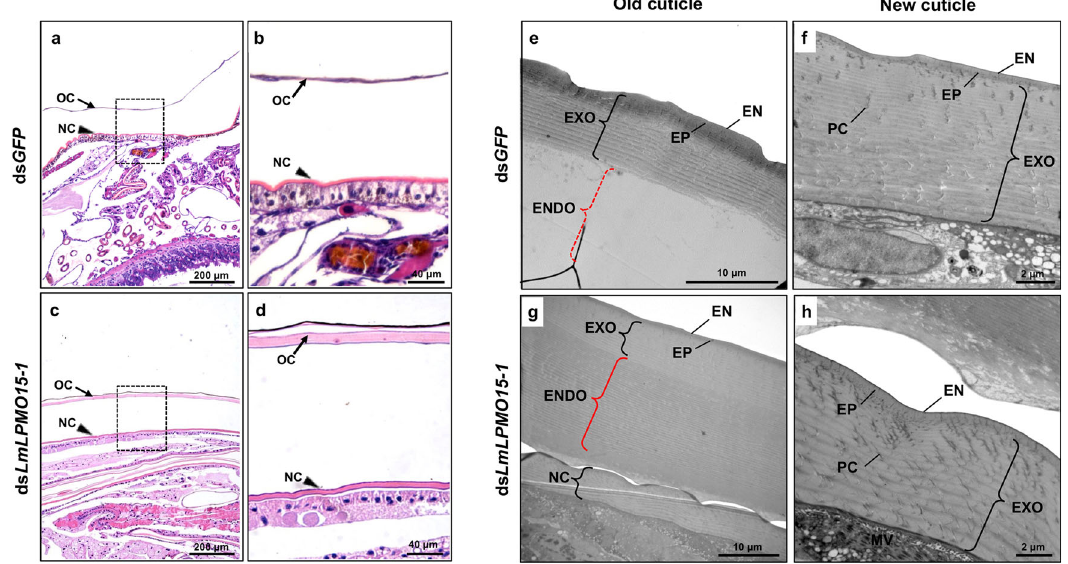
Fig. 6 Ultrastructure of cuticle from pharate adult of Lm LPMO15-1-de fi cient L. migratoria . a – d Paraf fi n sections (5 μ m) of third abdominal segments from pharate adults (5th instar day 9 nymphs) that had been injected with ds LmLPMO15-1 or ds GFP as the 5th instar day 1 nymphs were stained with hematoxylin and eosin. The old nymphal cuticle (OC) and newly forming adult cuticle (NC) (box in a , c ) were enlarged in b , d . The OC of ds LmLPMO15-1 - insects was signi fi cantly thicker than that of ds GFP -controls. e – h Ultrastructure of the old and new cuticles from each dsRNA-treated insect were analyzed by TEM. ds GFP -treated controls showed the degraded endocuticle (ENDO) in the overlying old cuticle (red dotted bracket in e ), while that of ds LmLPMO15- 1 -treated insects remained intact, exhibiting numerous chitinous horizontal laminae (red solid bracket in g ). EN, envelope; EP, epicuticle; EXO, exocuticle; ENDO, endocuticle; PC, pore